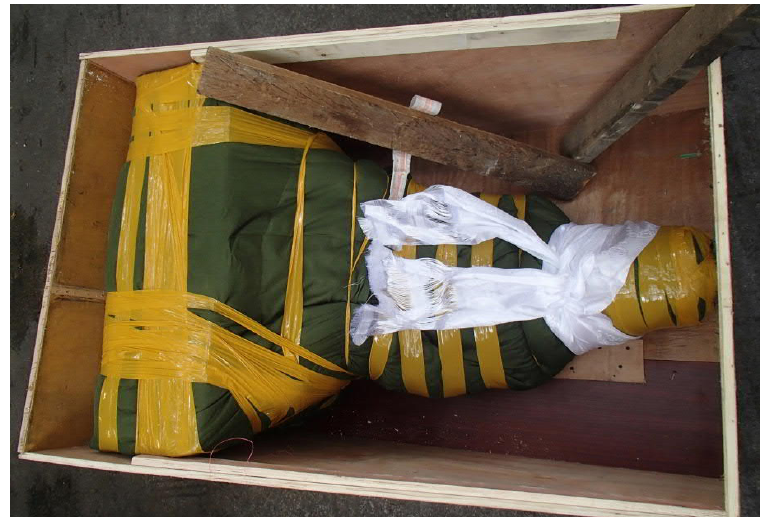
Figure 3. Transporting the Buddha from the Tibetan market (image taken from